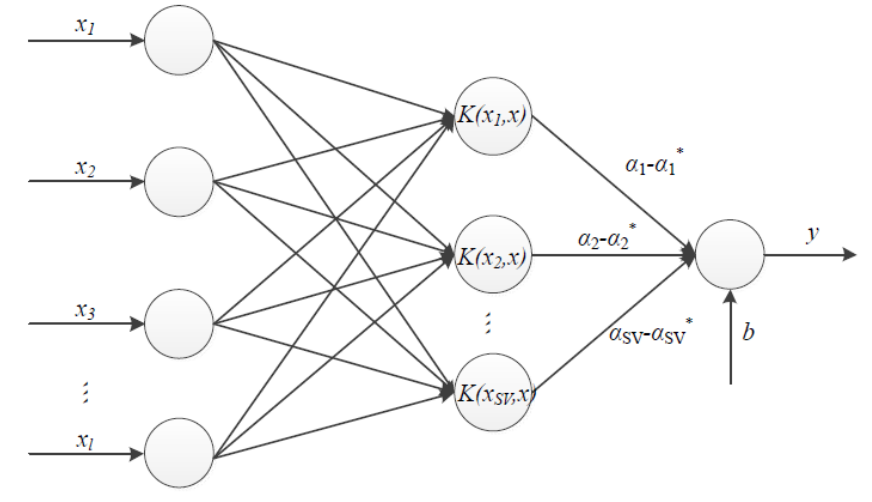
Figure 5. Structure of the nonlinear support vector machine.